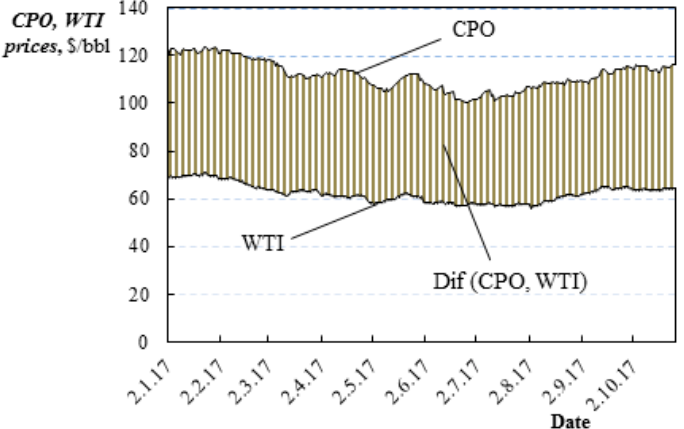
Figure 7. WTI crude oil price (full) vs. price of CPO (dotted) 1 = January 2017. Crude Palm Oil; West Texas Intermediate.